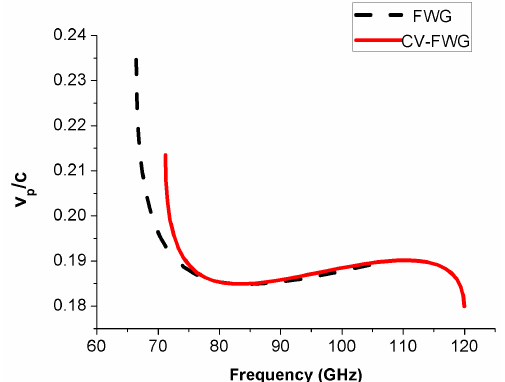
Figure 9. Normalized phase velocity of CV-FWG and conventional FWG.